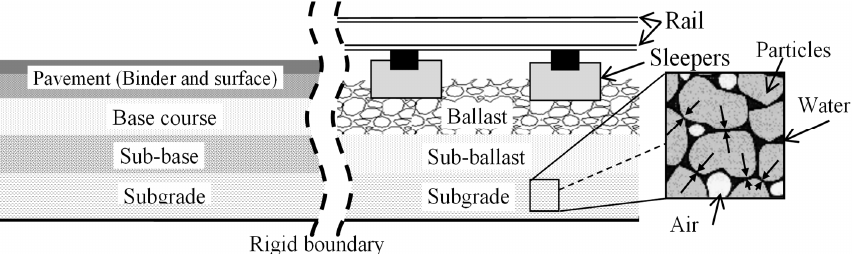
Figure 3. Profile of typical transport systems ( Heitor, et al. [44] , reproduced under the Creative commons Attribution license, CC BY ‐ NC ‐ ND 4.0).